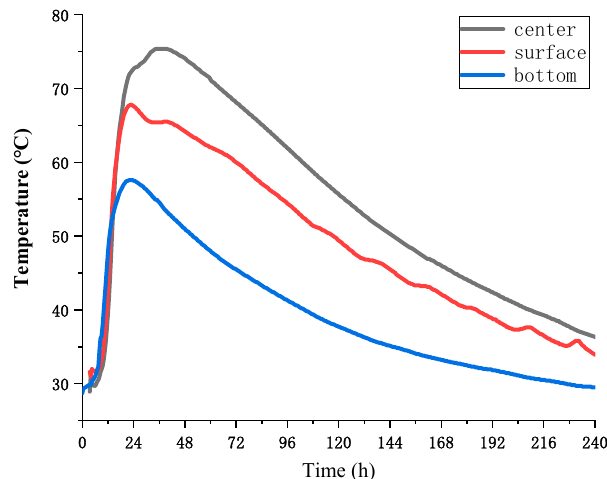
Figure 4. Comparison of the temperature rise of concrete in the simulation tools with the actual wall temperature.